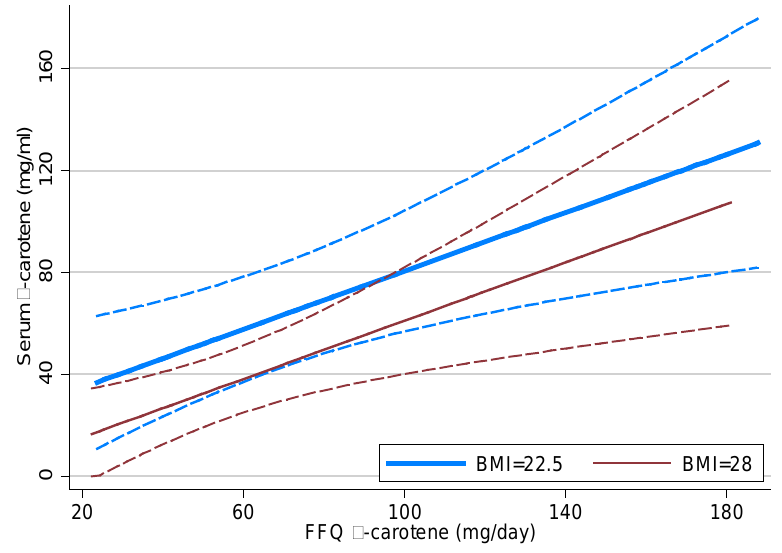
Figure 2. Estimate mean plasma β-carotene from multivariate linear regression model on FFQ β-carotene by BMI status, with 95% confidence